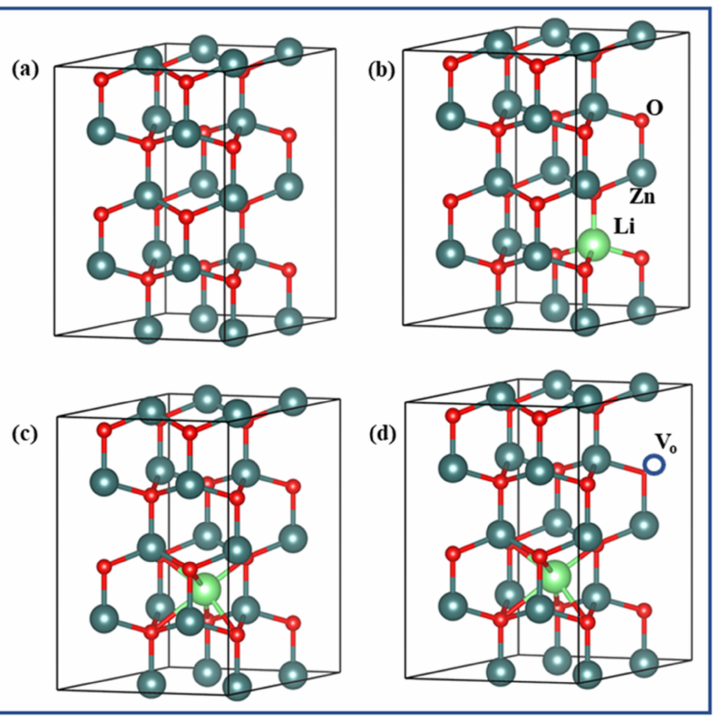
Figure 5. Researched ZnO models (Li atom-green ball, Zn atom-dark sky ball, and O atom-red ball): ( a ) Zn 16 O 16 , ( b ) Zn 15 LiO 16 , ( c ) Zn 16 Li in O 16 , and ( d ) Zn 16 Li in O 15 . V o = oxygen